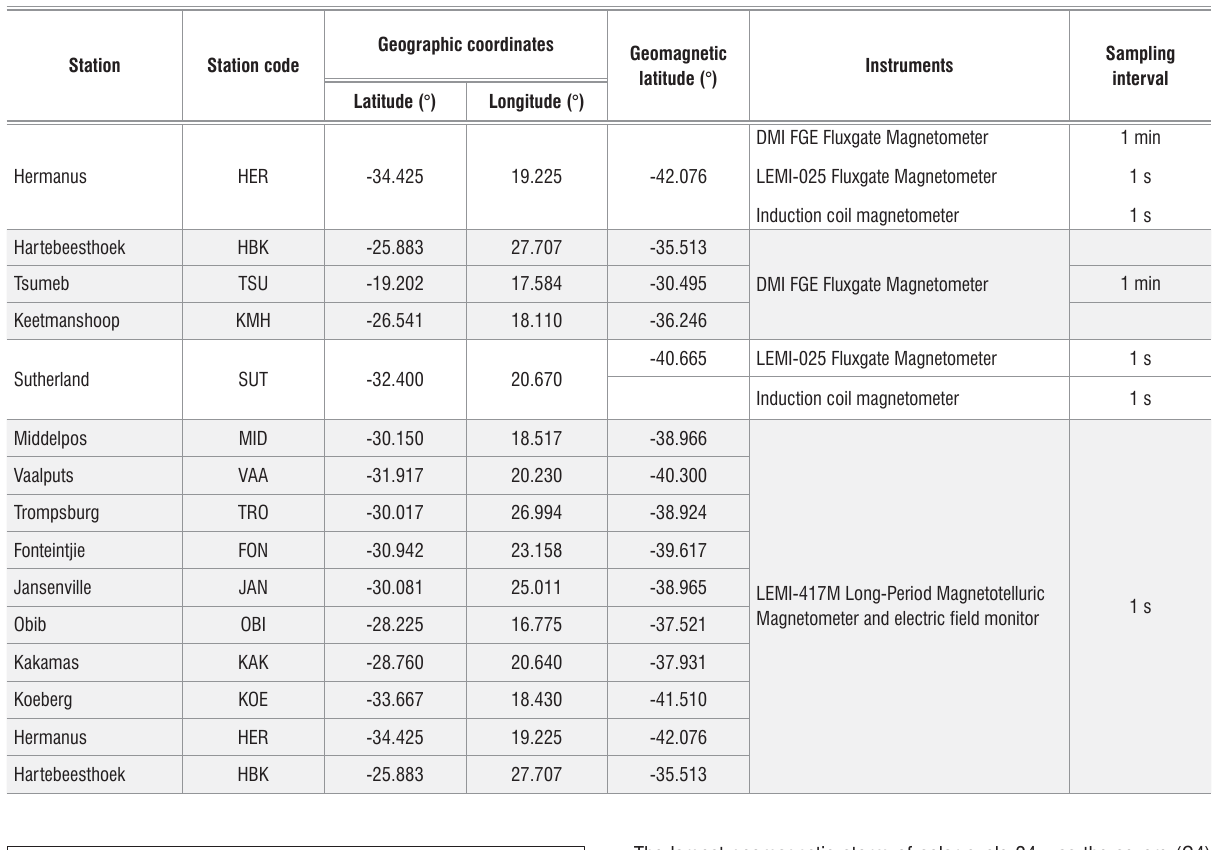
Table 1: The location of SANSA’s geomagnetic network stations over southern Africa